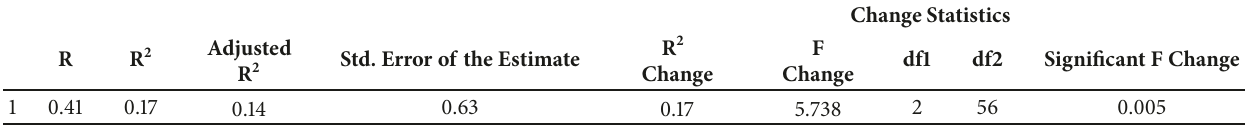
Table 4: Best fitting multiple linear regression LRJT Right Hand Reaction